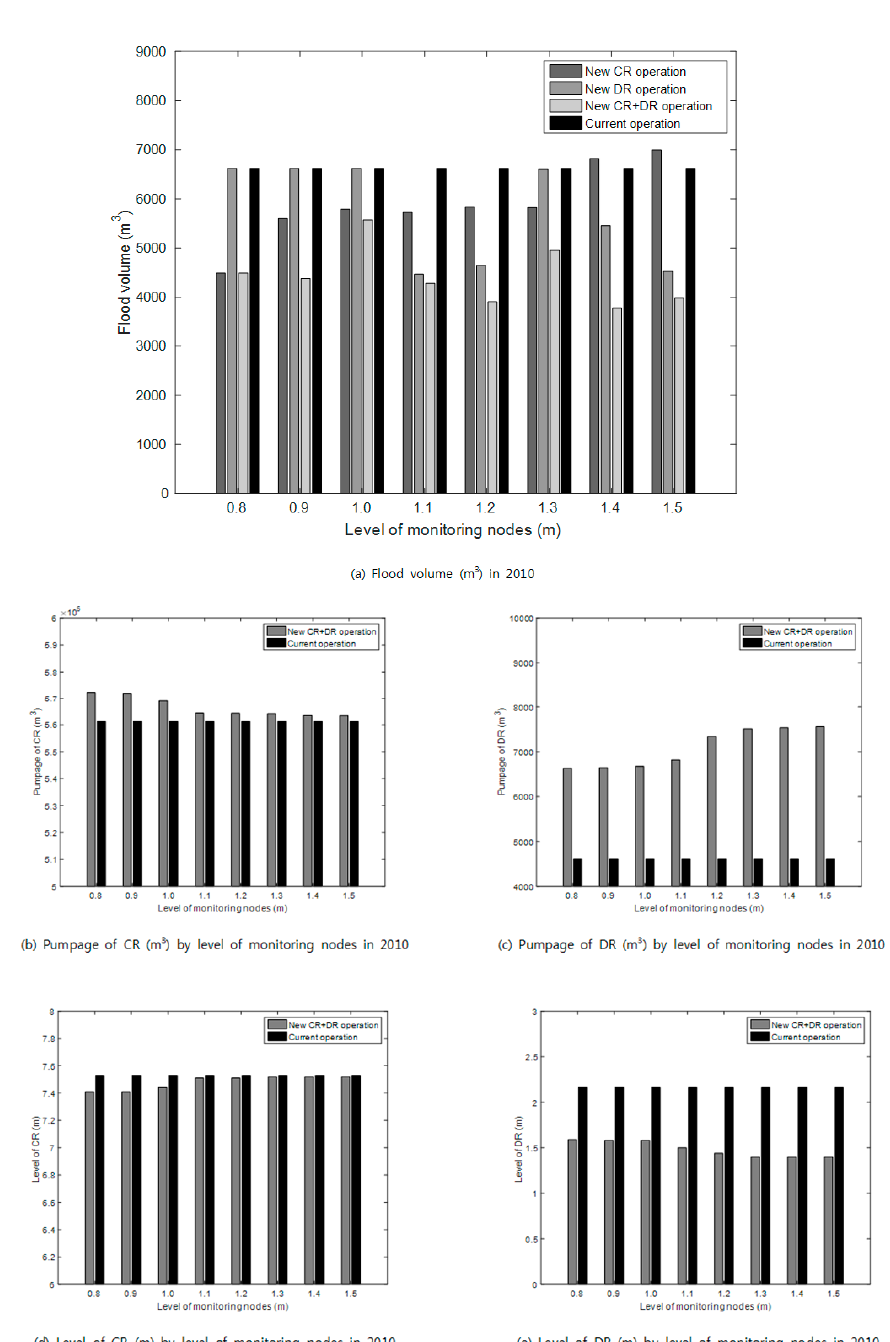
Figure 14. Results of cooperative operation in 2010.